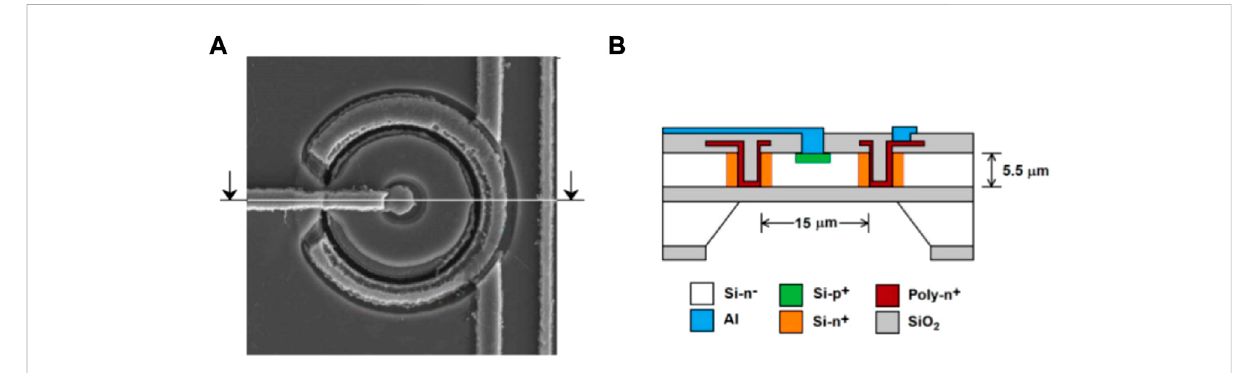
FIGURE 9 Front-face (A) and schematic representation of the cross-section (B) of a 3D-cylindrical microdetector unit-cell. Source: